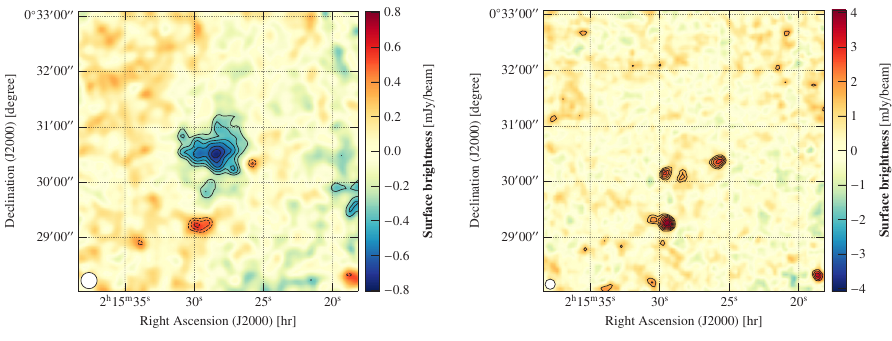
Figure 1. NIKA2 maps of the cluster in the 150 GHz ( left ) and 260 GHz ( right ) bandpasses. Both maps are shown in a 5’ 5’ area centered on the observed coordinates. The NIKA2 instrumental beam’s × FWHM is represented as a white disk in the bottom left corner of each map. Contours show SNR levels starting from 3 σ with a 1 σ spacing. The left (right) map is smoothed with a 10” (6”) gaussian kernel ± for display